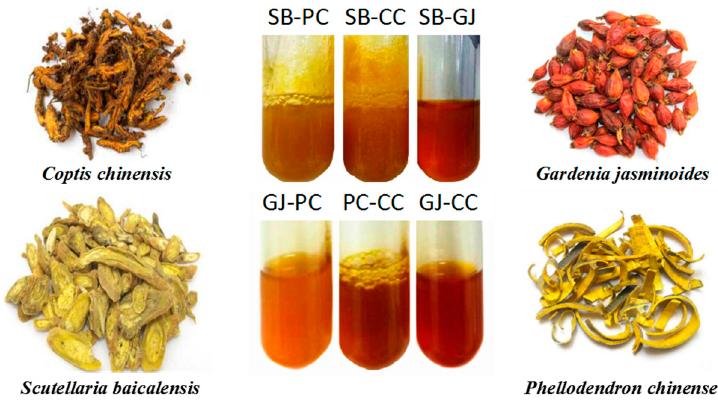
Figure 1. The experimental phenomena of SB-PC SB-CC, SB-GJ, GJ-PC, PC-CC, GJ-CC.